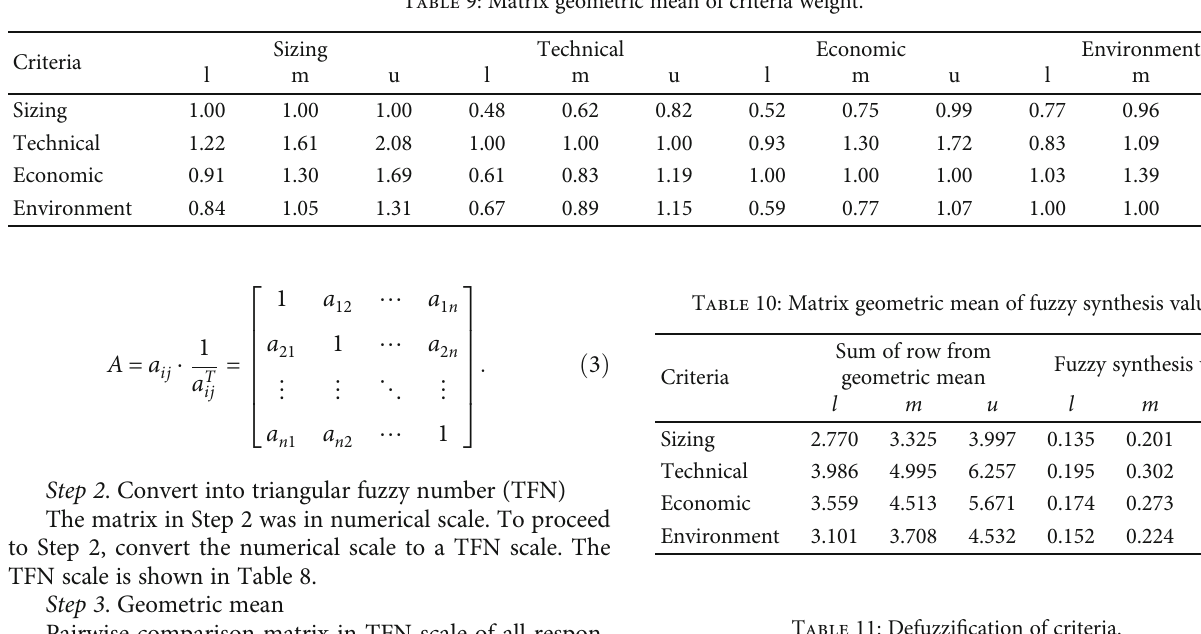
Table 9: Matrix geometric mean of criteria